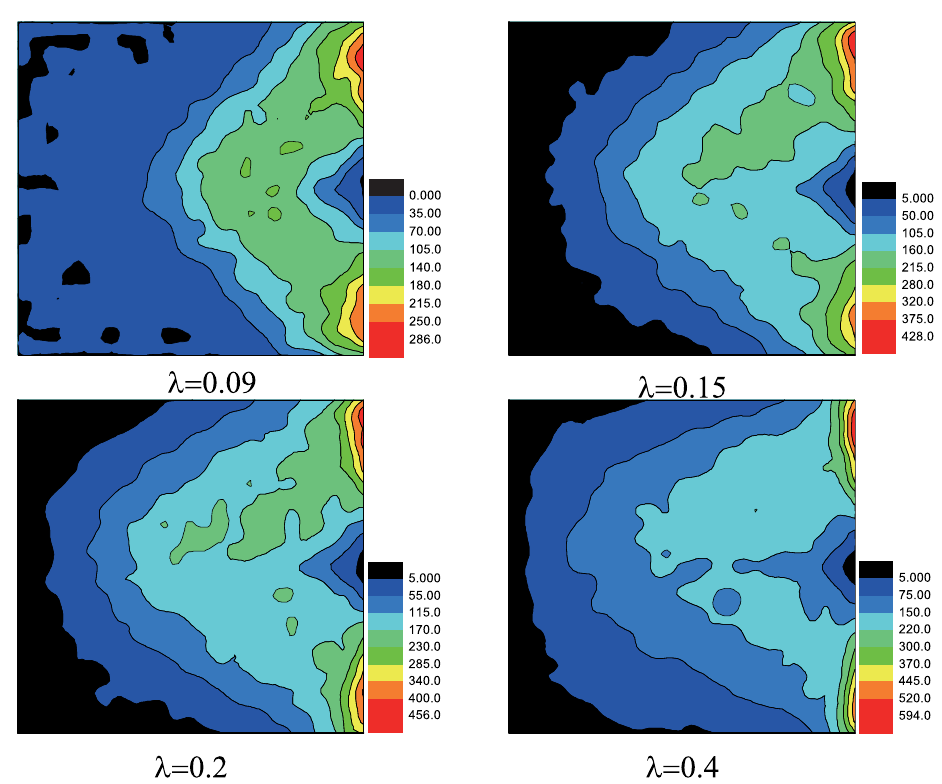
Fig 7. The spatial distribution of the wounded people with different λ . The color reflect the number of accumulated wounded people in different area. Here, the scale of the room is 25 × 25, w = 3 and N = 500. Initially, N II = 5. The data above are obtained by 5000 different realizations.